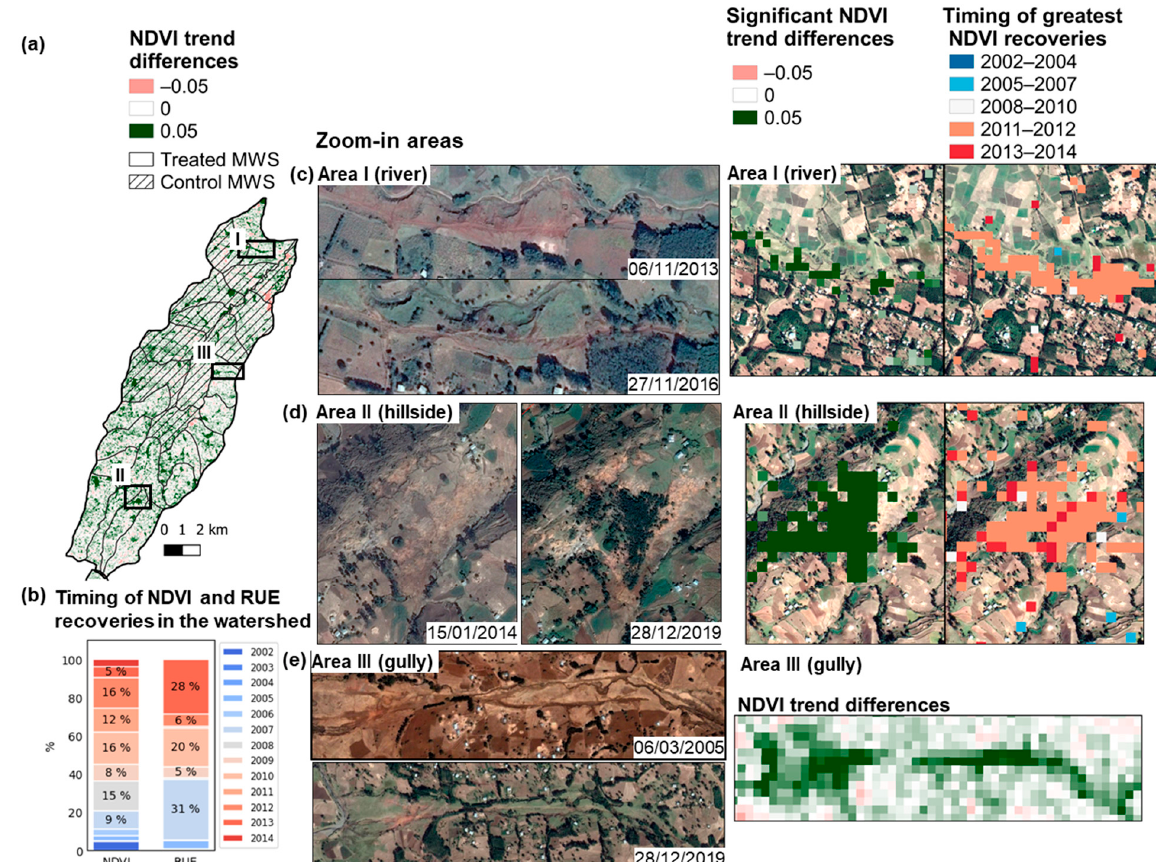
Figure 7. Watershed of Yilmana Densa. ( a ) NDVI trend differences (slope of 2011–2018 minus slope of 2002–2010); ( b ) Timing of the largest NDVI and RUE recoveries; Zoom-in areas showing ( c ) a decline of eroded soil at a riverbank (area I), ( d ) an increase in vegetation along a hillside (area II) and ( e ) an increase in vegetation in and nearby a gully (area III) with corresponding trend patterns.